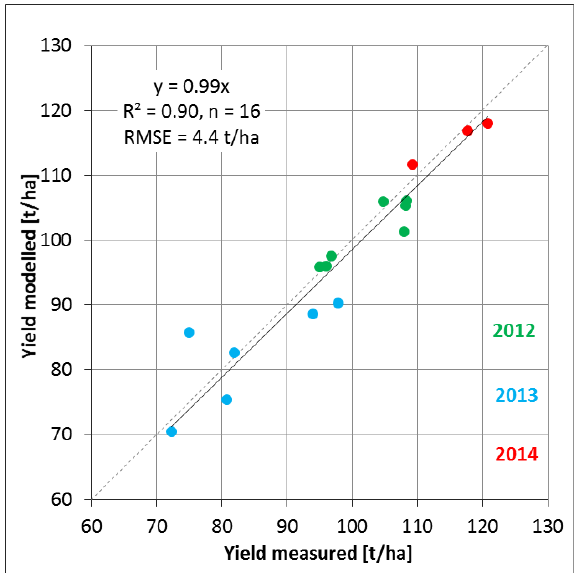
Figure 8: Yield validation on field